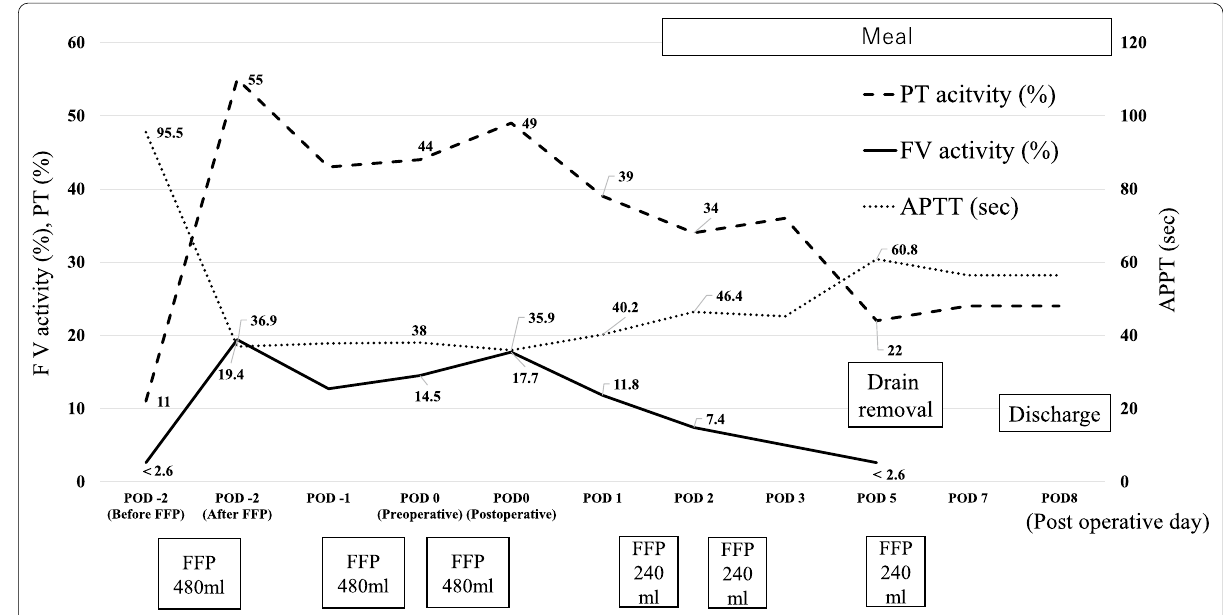
Fig. 3 Perioperative treatment course and changes in coagulation data. FV activity increased with FFP transfusion and remained at approximately 15%. The patient consumed food on the first night after the operation, the drain was removed on the fifth day postoperatively, and the patient was